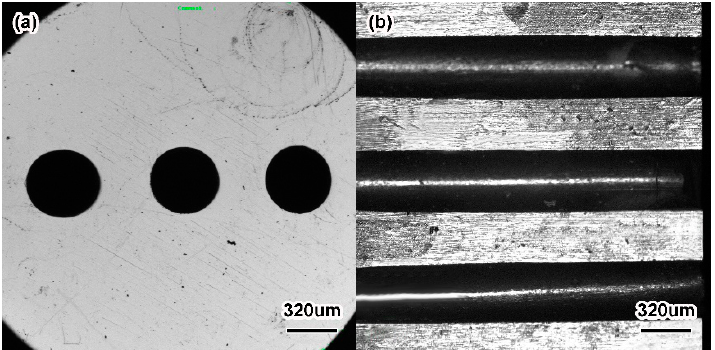
Figure 16. Partial view of sintered micro-holes: ( a ) overhead view; ( b ) cutaway view. Table 5. Linear shrinkage of ZrO 2 nozzles with micro holes sintered at 1500 ◦ C (%). Relative Density